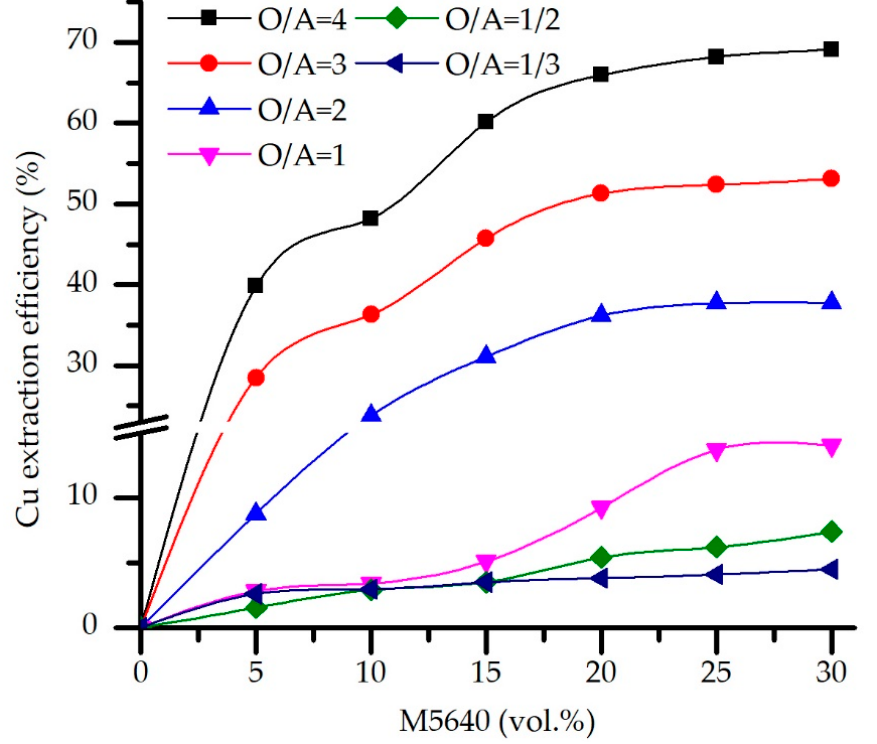
Figure 1. Copper extraction efficiency as a function of M5640 concentration and O/A phase ratio for the feed pH 0, temperature 20 °C, and contact time 10 min.